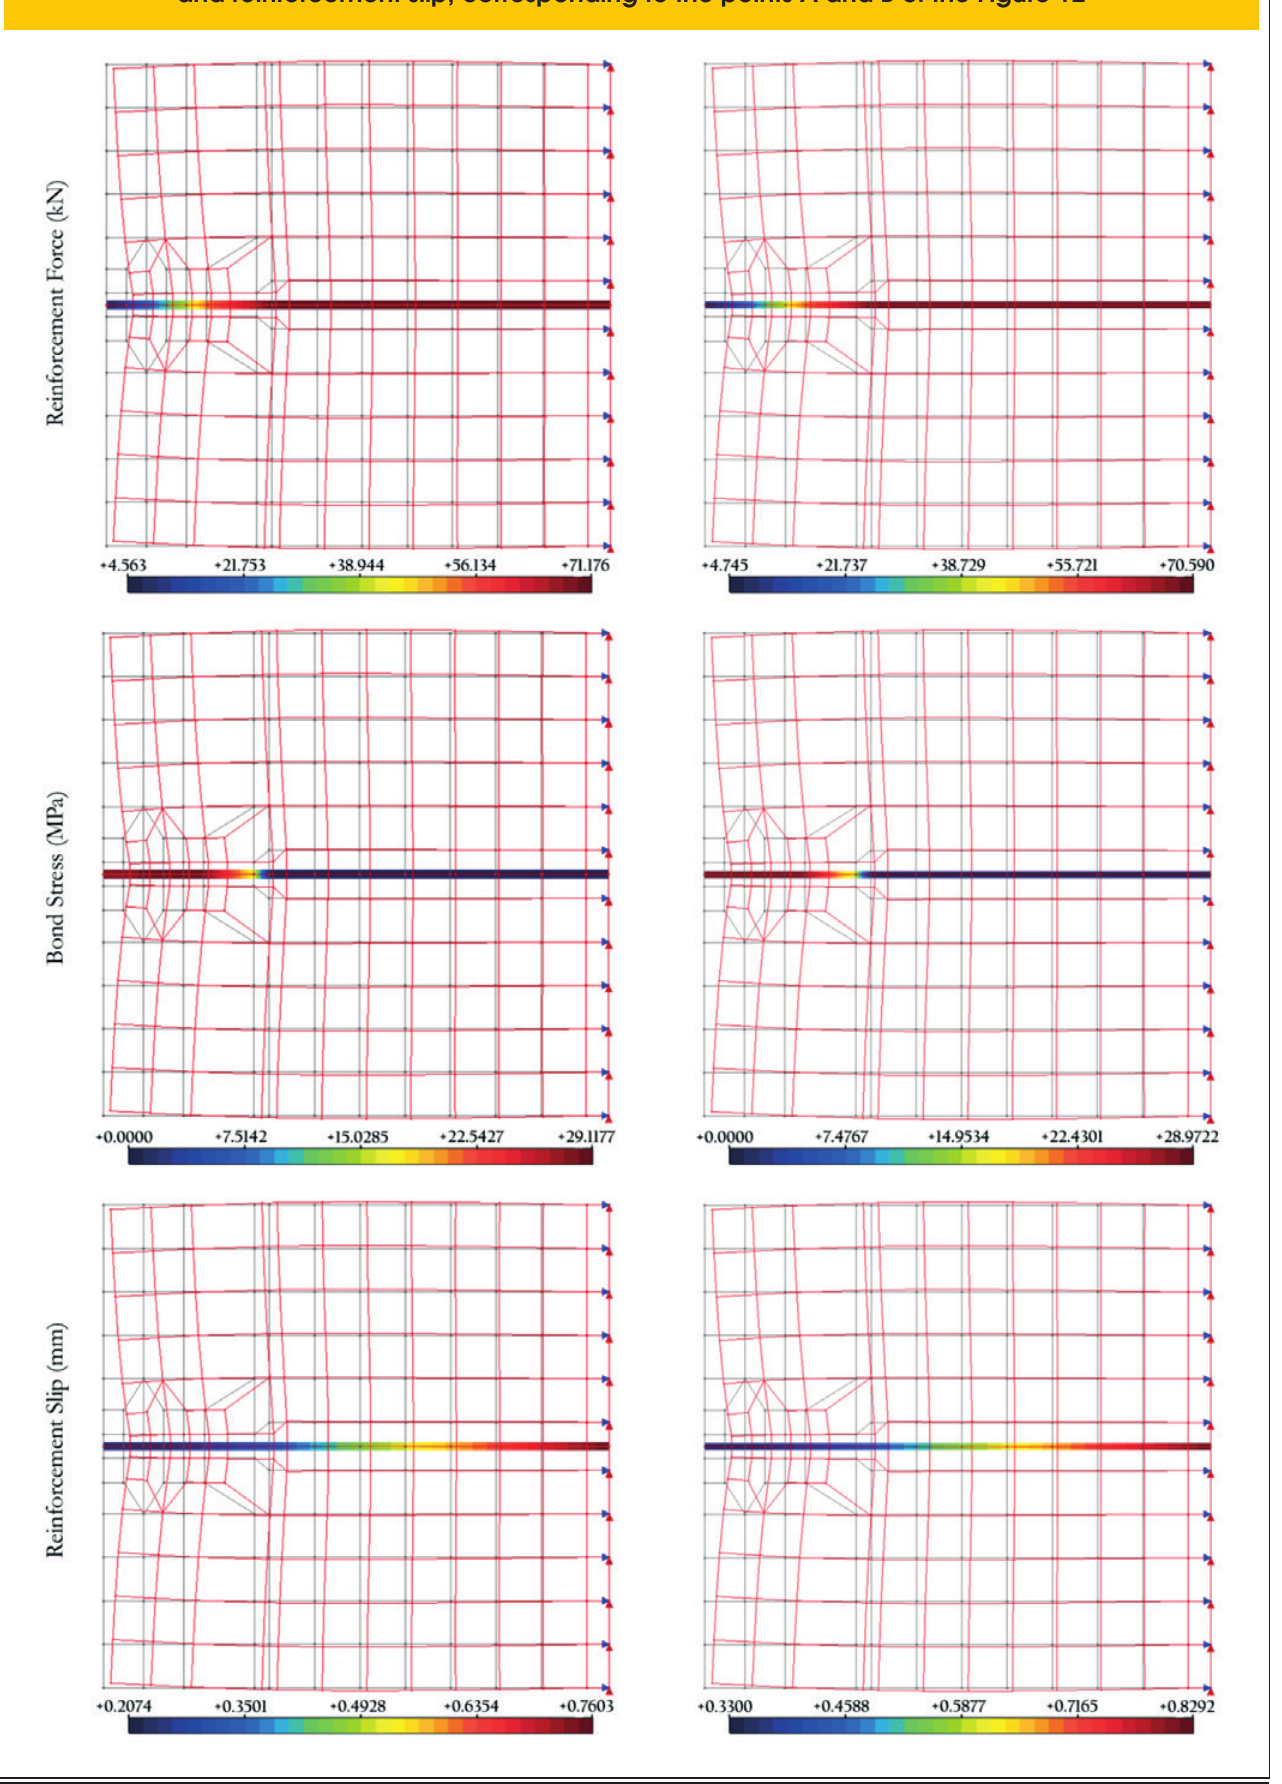
Figure 13 – Mesh's deformed shape and variation of the reinforcement force, bond stress and reinforcement slip, corresponding to the points A and B of the Figure